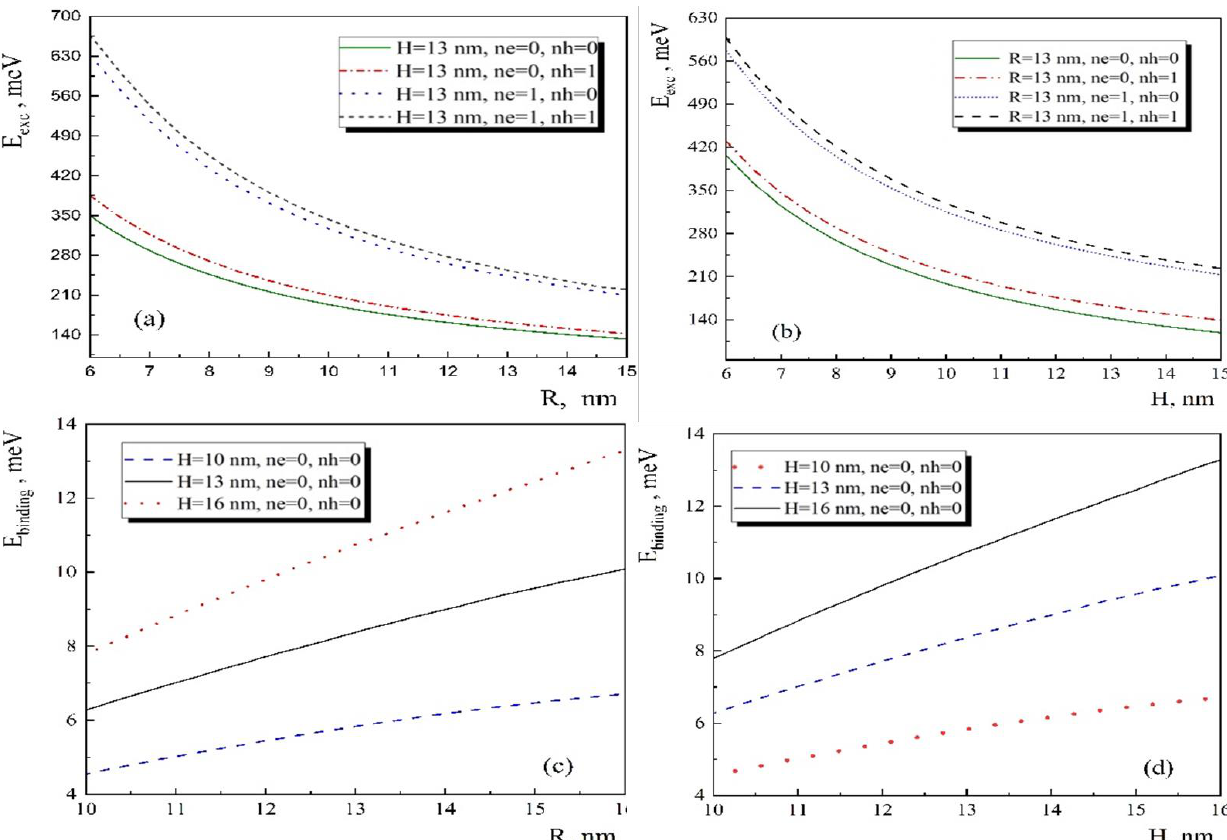
Figure 4. The exciton energy and binding energy depend on the geometrical parameters of the conical QD. ( a , b ) dependence of the exciton energy on radius and height for the first four states, respectively. ( c , d ) dependence of the binding energy on the radius and height for the ground state, respectively.